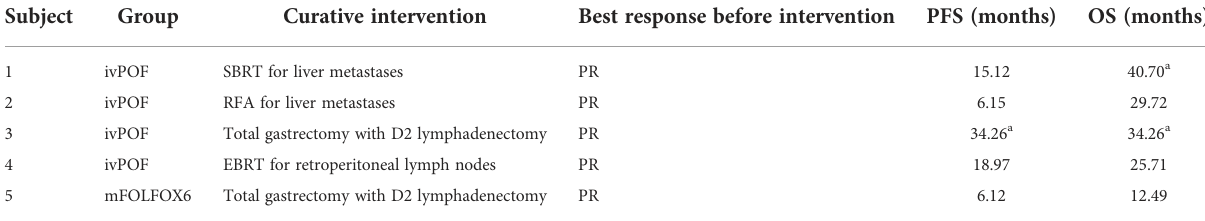
TABLE 6 Therapeutic ef fi cacy in subjects who underwent curative